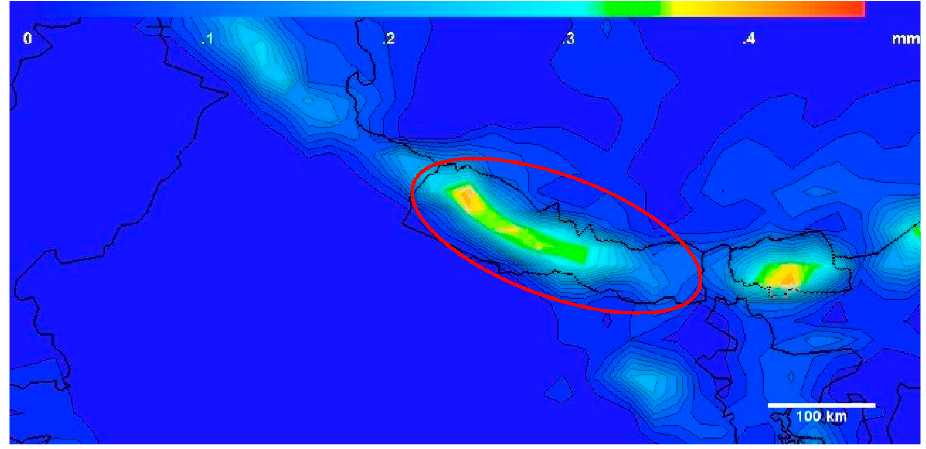
Figure 9. Total precipitable water in mm (shown in legend at upper part of Figure) over Nepal (shown by a red coloured circle area) at 1830 UTC on 15 June 2018 from the MERRA reanalysis with horizontal resolution of 0.5 ◦ × 0.67 ◦.